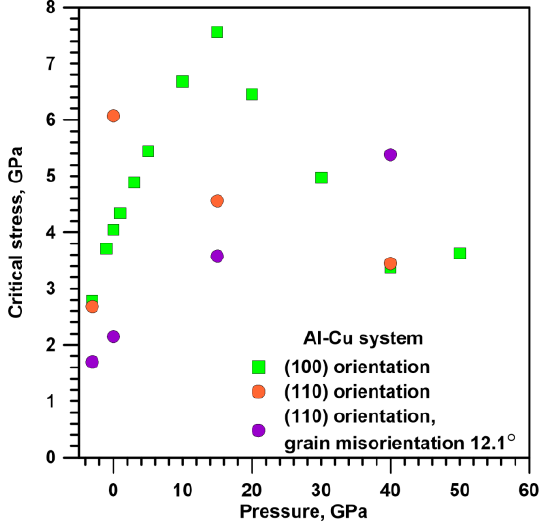
Figure 16. Influence of the interface orientation on the pressure dependence of the critical shear stresses of plasticity initiation in Al-Cu bimetallic system at 300 K.